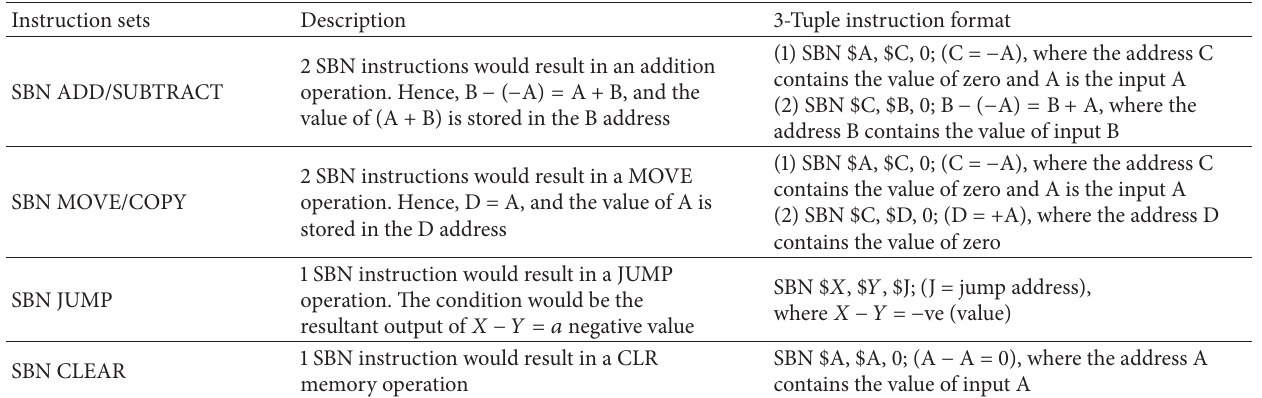
Table 3: The SBN instruction